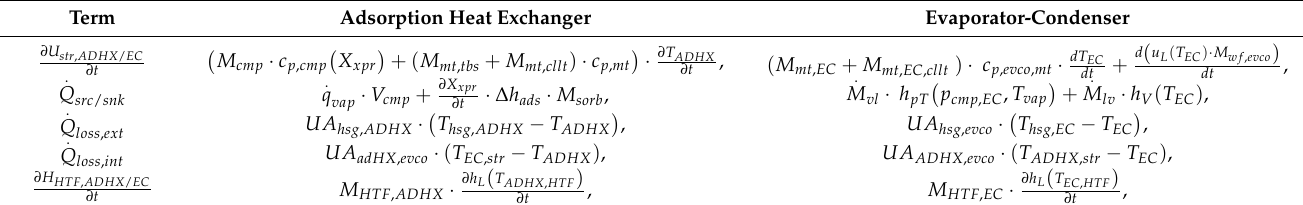
Table 3. Terms of Equations (8) and (9) detailed for adsorption heat exchanger and